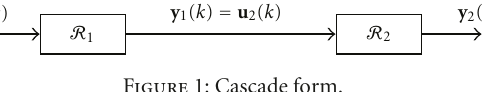
Figure 1: Cascade